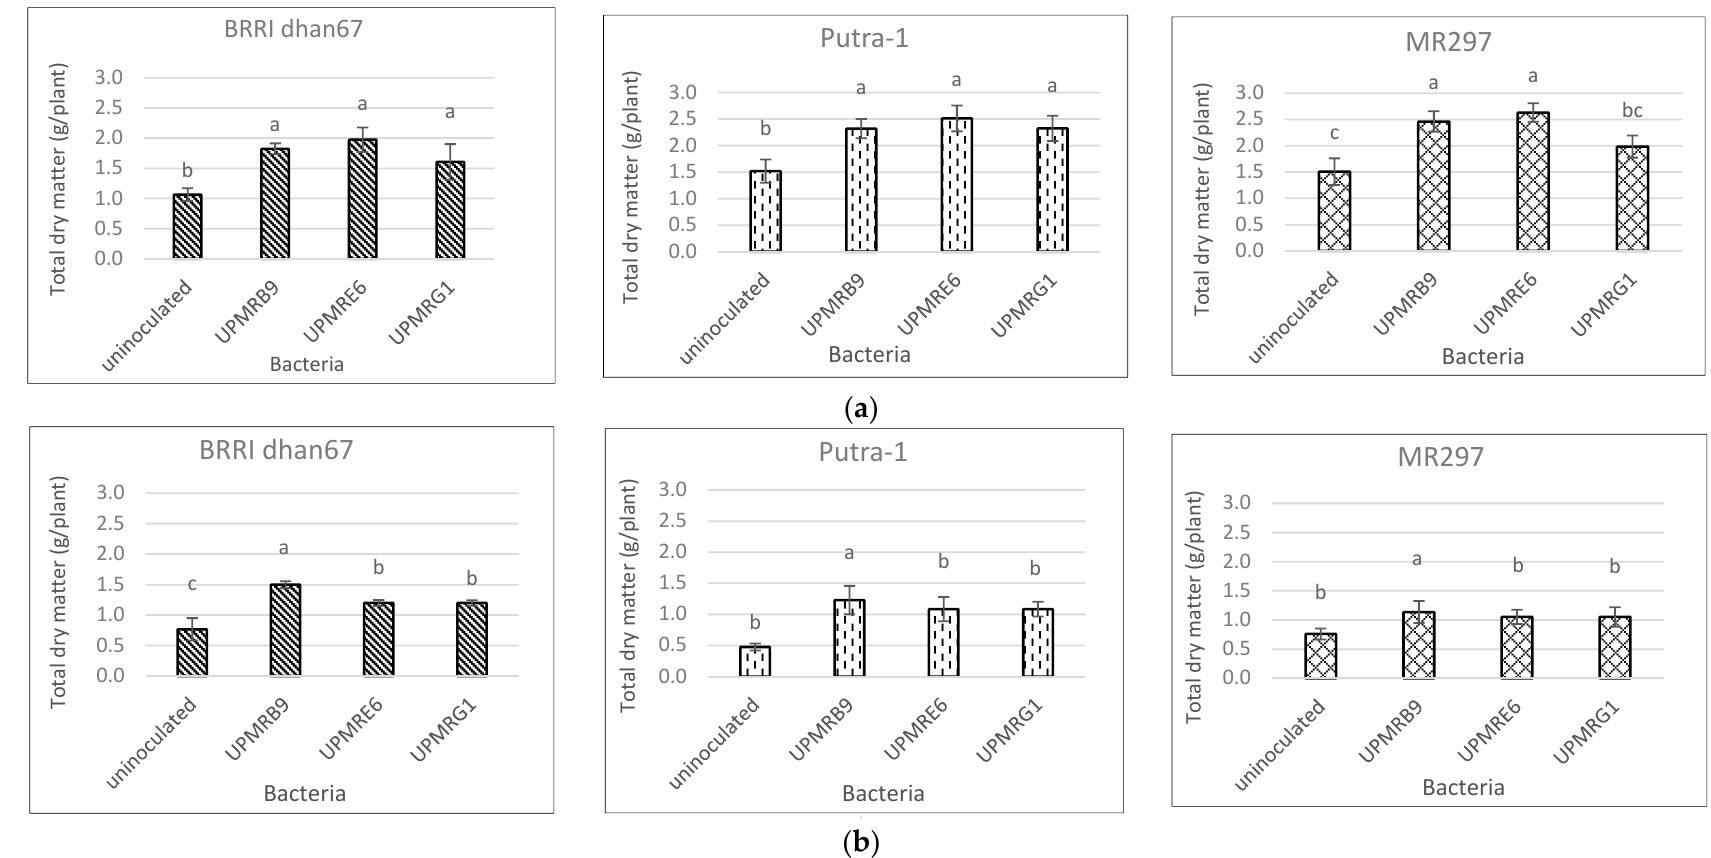
Figure 5. ( a ) Effect of bacterial inoculation on total dry matter production of three rice varieties under non-saline conditions. Means with the same letter in each variety do not differ significantly using Tukey’s test at p > 0.05. ( b ) Effect of bacterial inoculation on total dry matter production of three rice varieties under saline conditions. Means with the same letter in each variety do not differ significantly using Tukey’s test at p > 0.05.